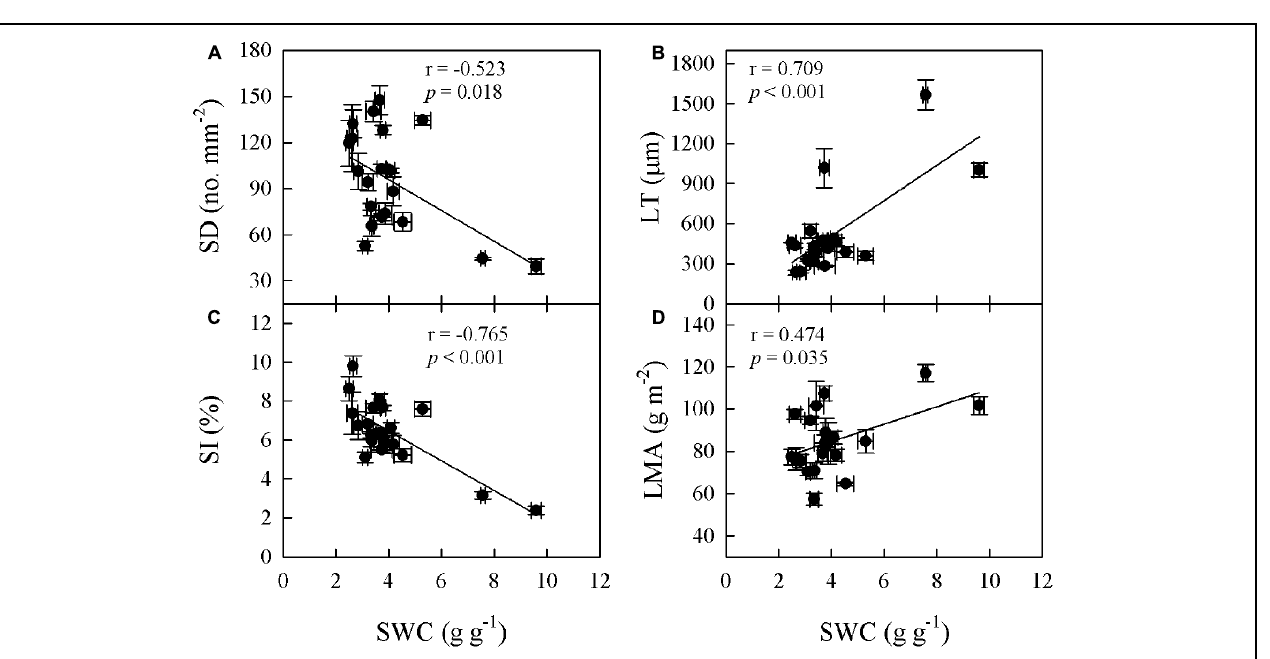
cuticle (UCT), lower cuticle (LCT), upper epidermis (UET), lower epidermis (LET), and the whole leaf (LT) were determined with the IMAGEJ program. Leaf density (LD) was calculated as